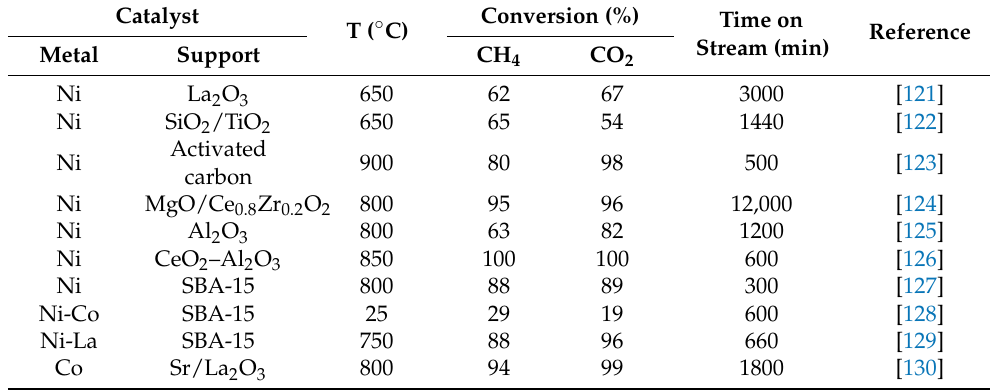
Table 1. Comparison of the catalyst activity in DRM (feed-gas ratio CH 4 :CO 2 =